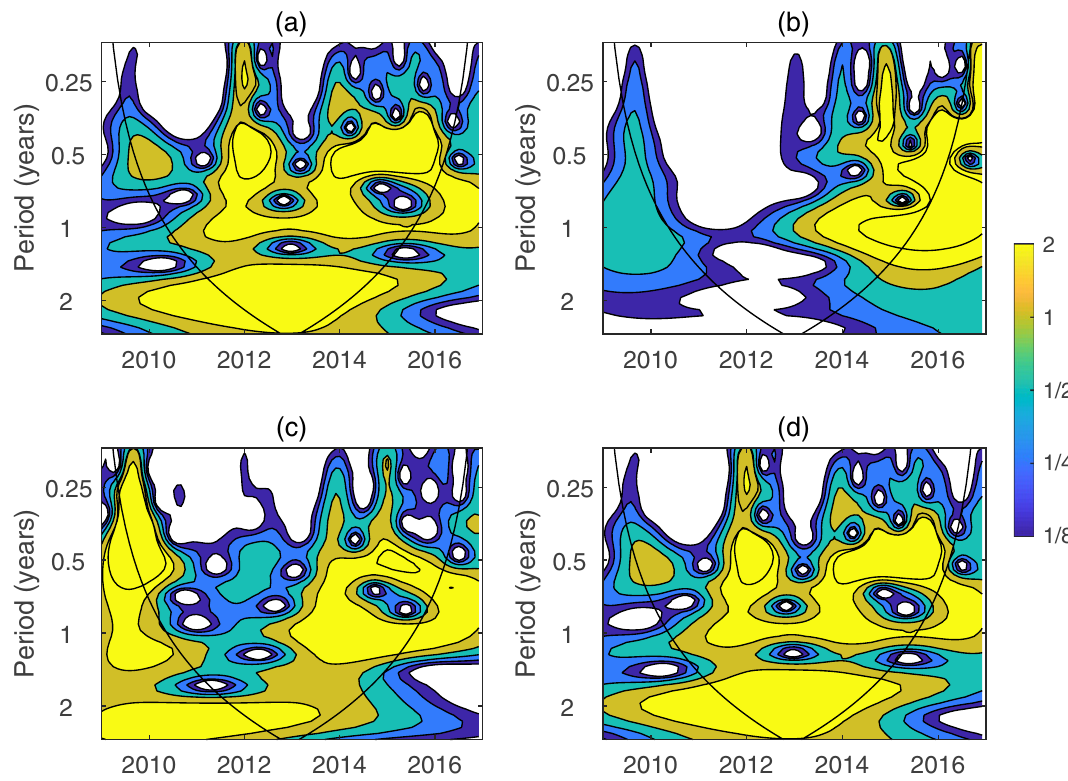
Figure 10. The results of wavelet analysis, where the monthly influenza data of ( a ) Shanghai, ( b ) Beijing, ( c ) Jiangsu province and ( d ) Tianjin obtained from CDC since